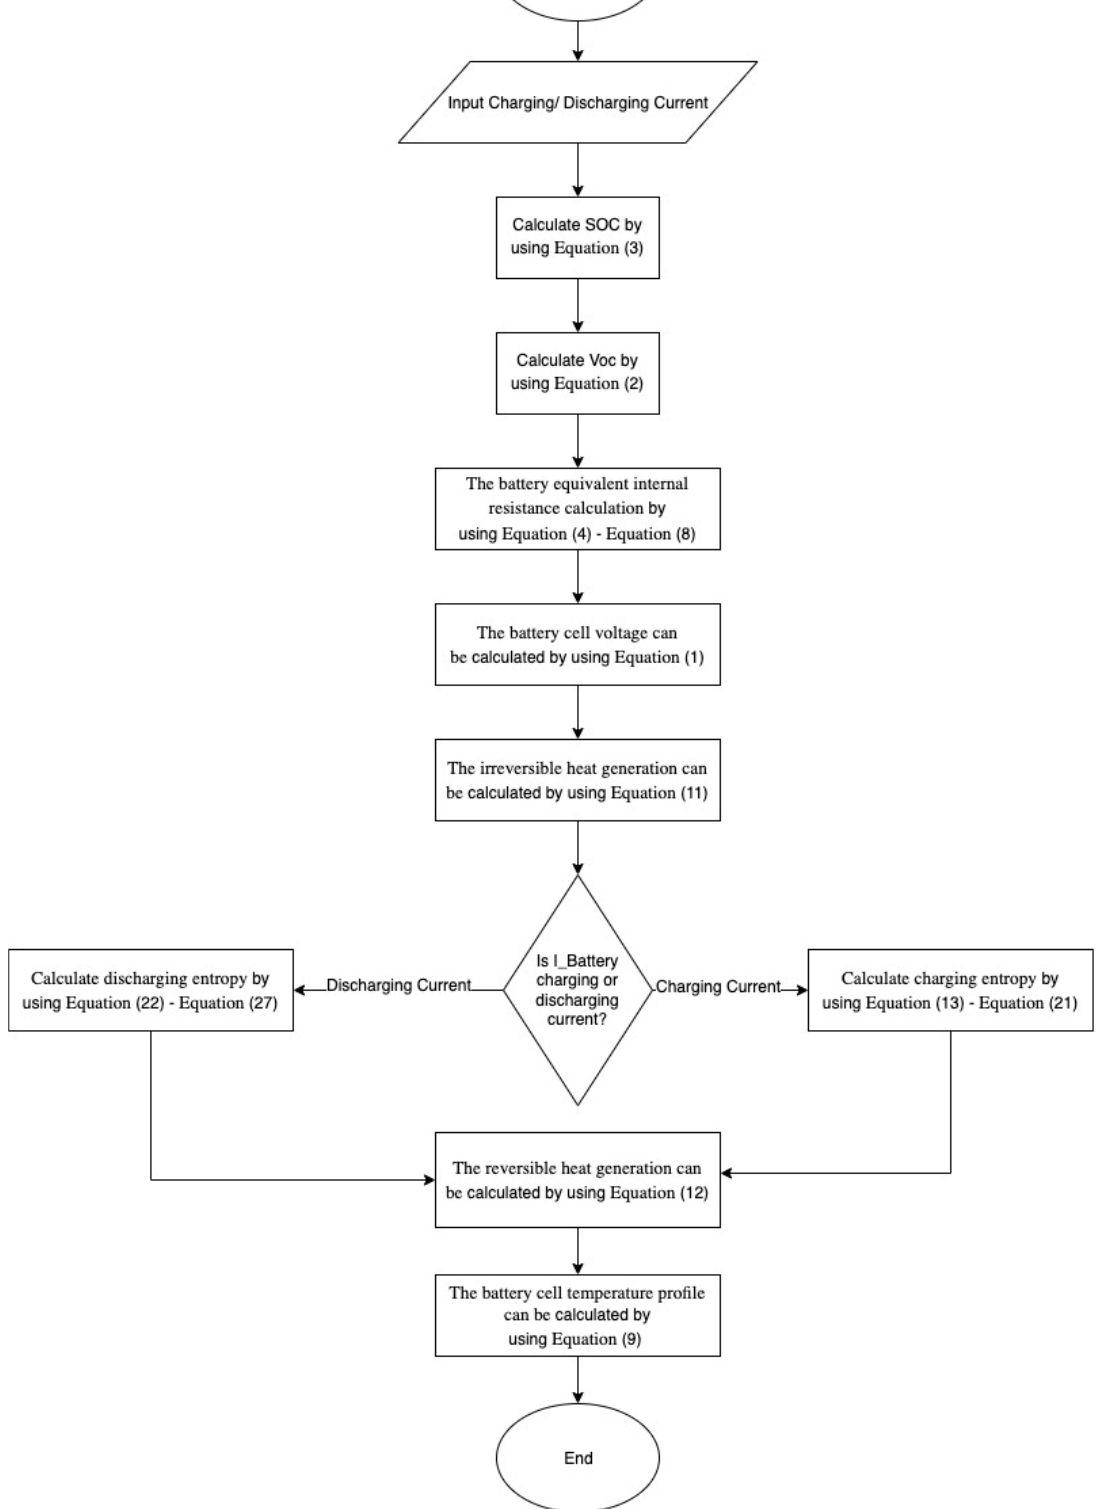
Figure 3. A workflow view of the proposed electrical temperature model.